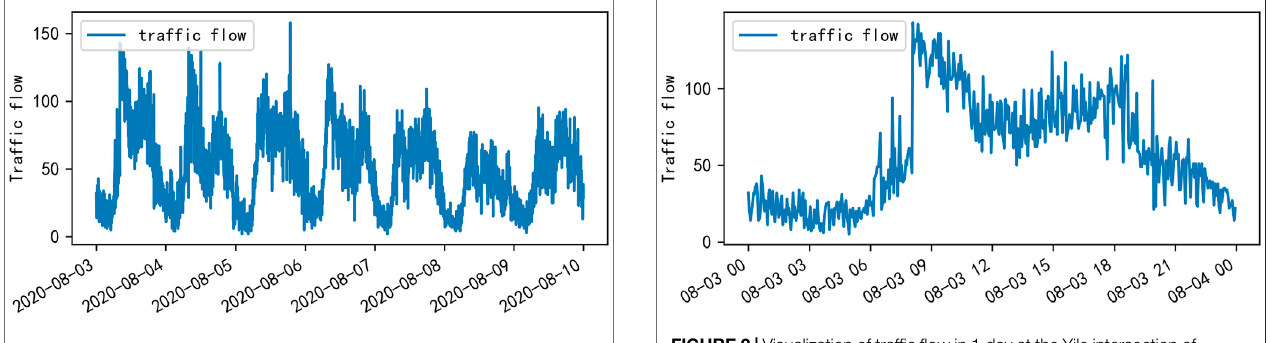
FIGURE1| Visualizationoftraf fi c fl owin1 weekattheYileintersectionof Wenyi Road.